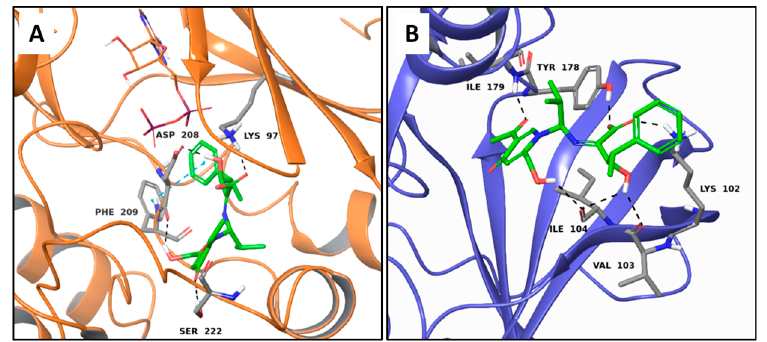
Figure 2. Molecular interactions of erinacerin P and the anticancer targets: ( A ) Protein target, MEK1 (PDB: 4ARK). Protein is shown as an orange cartoon; ( B ) Protein target, SGK1 (PDB: 3HDM). Protein is shown as violet cartoon. Erinacerin P is represented as green carbon sticks. H-bonds and π - π interactions are displayed as dashed black and cyan lines, respectively. Amino acid residues involved in the molecular interactions are shown as gray sticks.